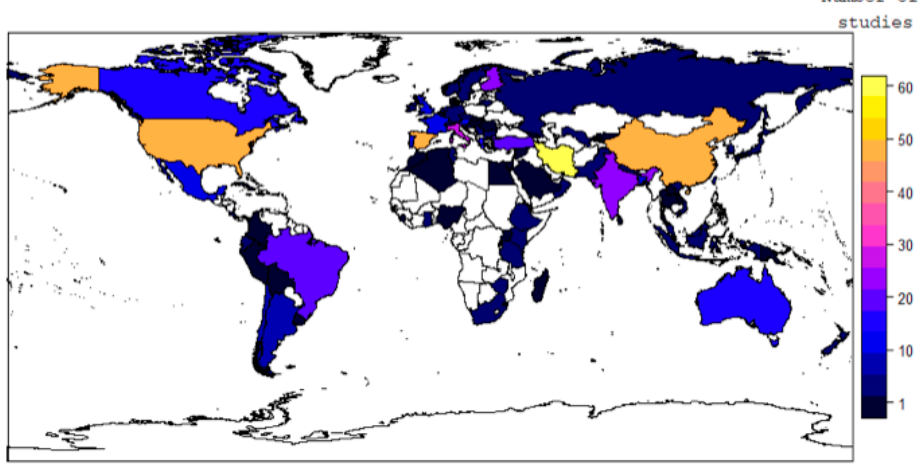
Figure 2. Number of studies per country in the assessment.